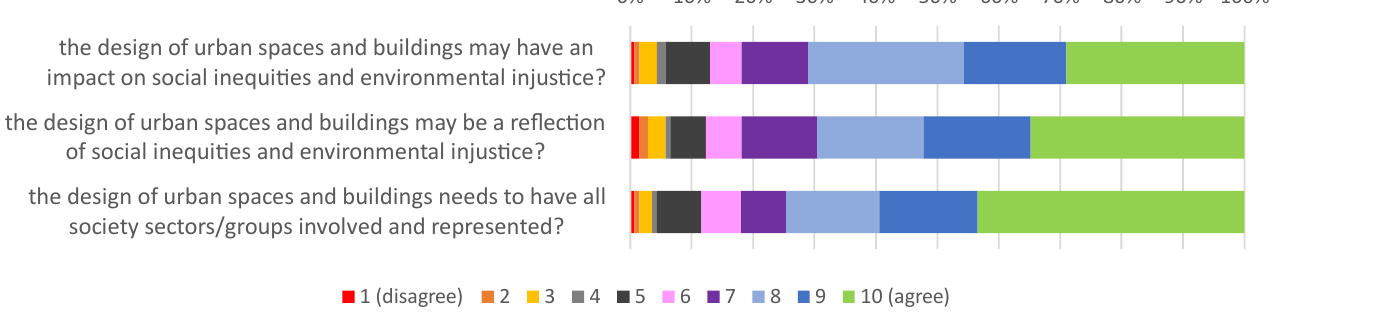
Figure 10. Perception of the relation between built the environment and social aspects.